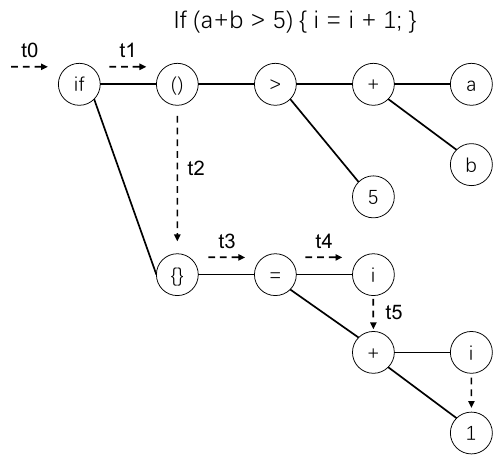
Figure 5. Candidate paths of the